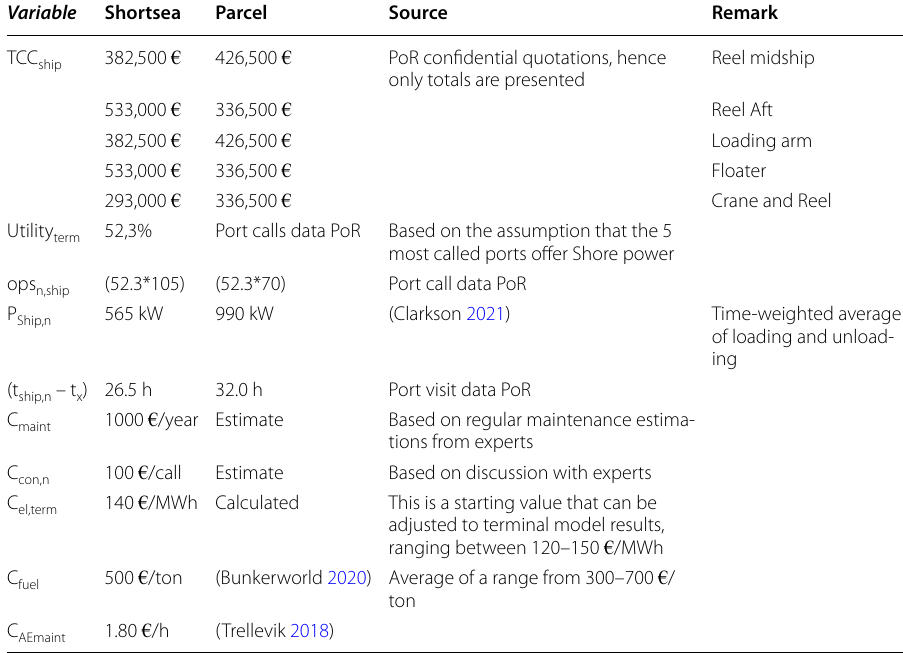
Table 3 Overview of shipside related input for the model. Source : Authors Variable Shortsea Parcel